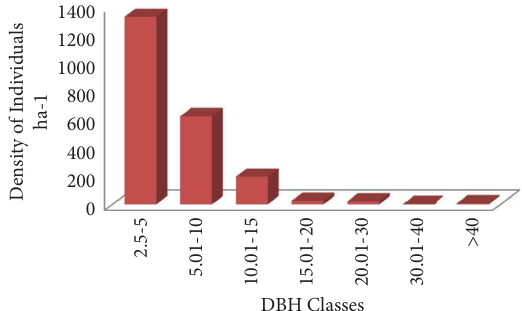
Figure 3: Distributions of woody plant individuals in the diferent DBH classes.